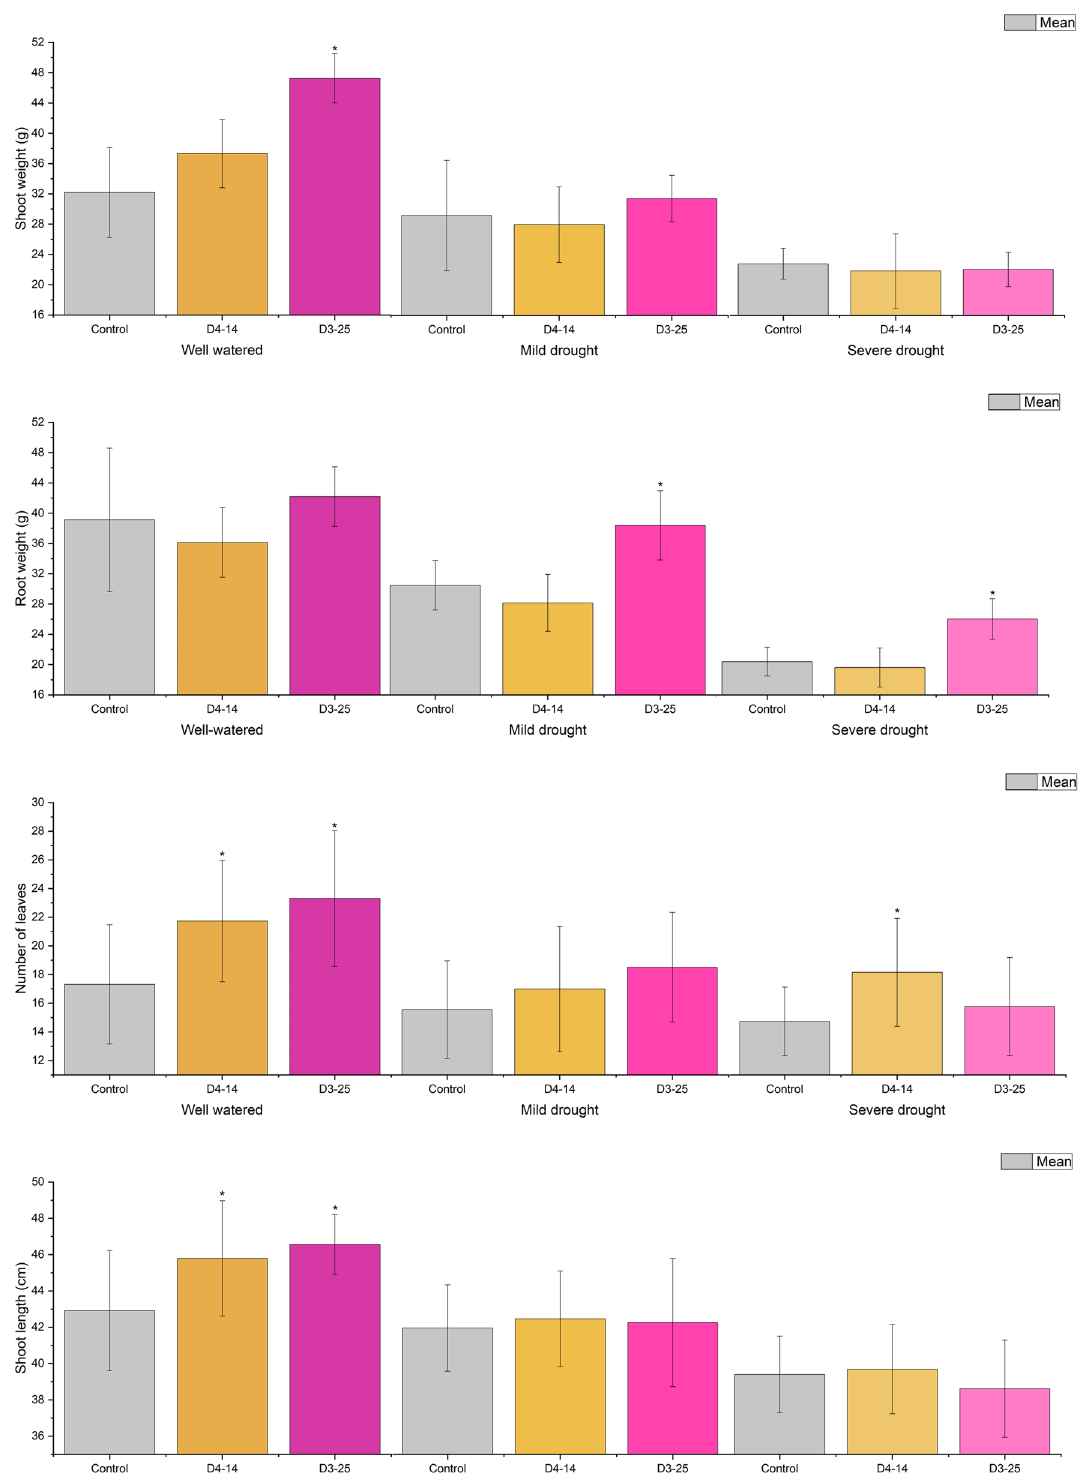
Figure 6. Growth of wheat plants inoculated with Cf D3-25 (pink) and Ar sp. D4-14 (orange) and control (grey), grown under well-watered (300 mL every 48 h), mild drought (150 mL every 48 h) and severe drought conditions (50 mL every 48 h)—( a ) wet shoot weight and ( b ) wet root weight ( c ) Number of leaves and ( d ) shoot lengths. Error bars show standard deviation. Stars indicate bacterial treatments that were significantly difference from